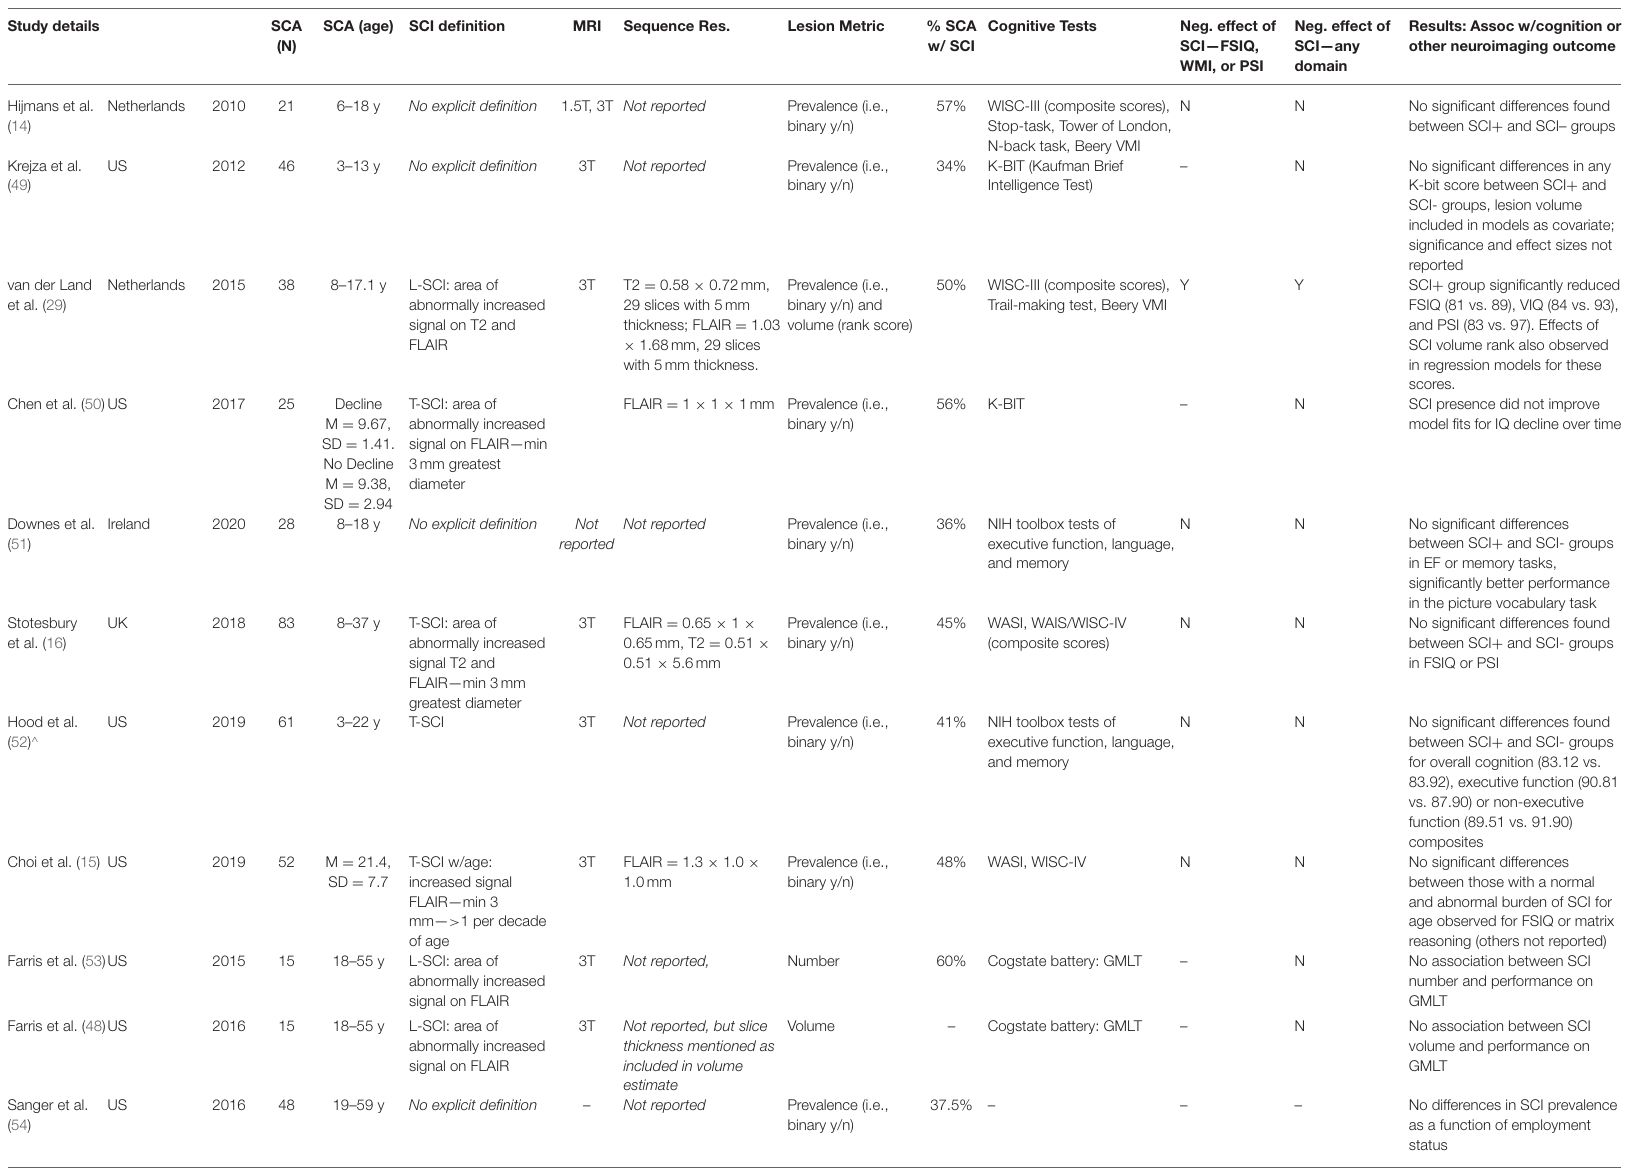
TABLE 5 | Overview of high-resolution MRI studies examining impact of SCI on cognitive outcomes in patients with SCA.